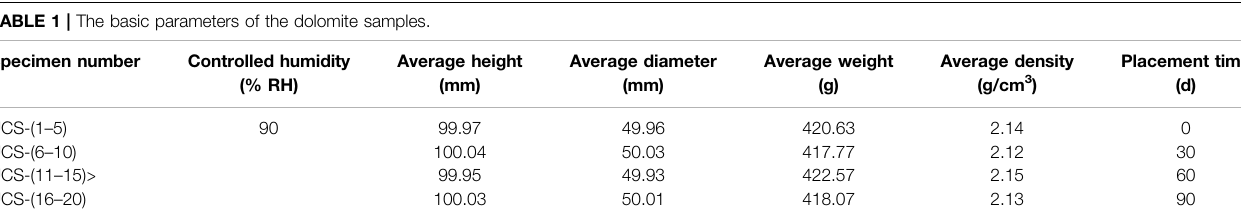
TABLE 1 | The basic parameters of the dolomite